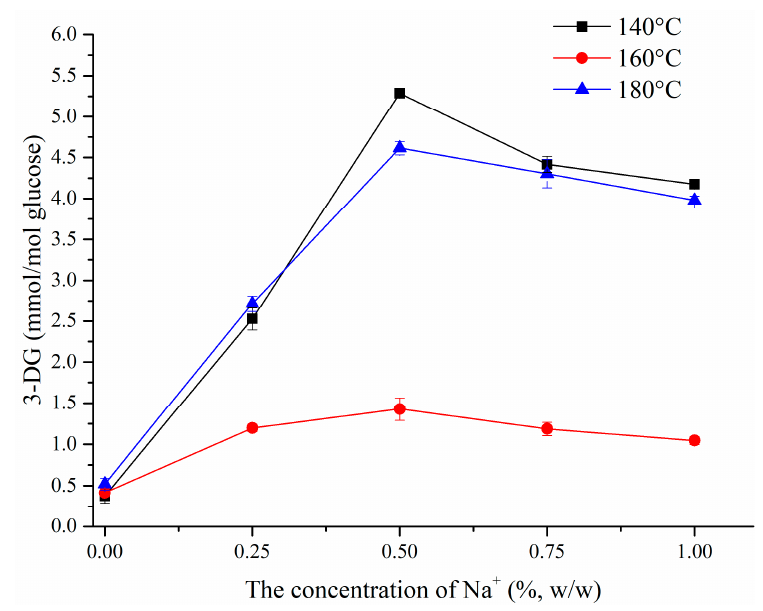
Figure 3. Sodium and temperature-dependent formation of 3-DG in model reaction systems.